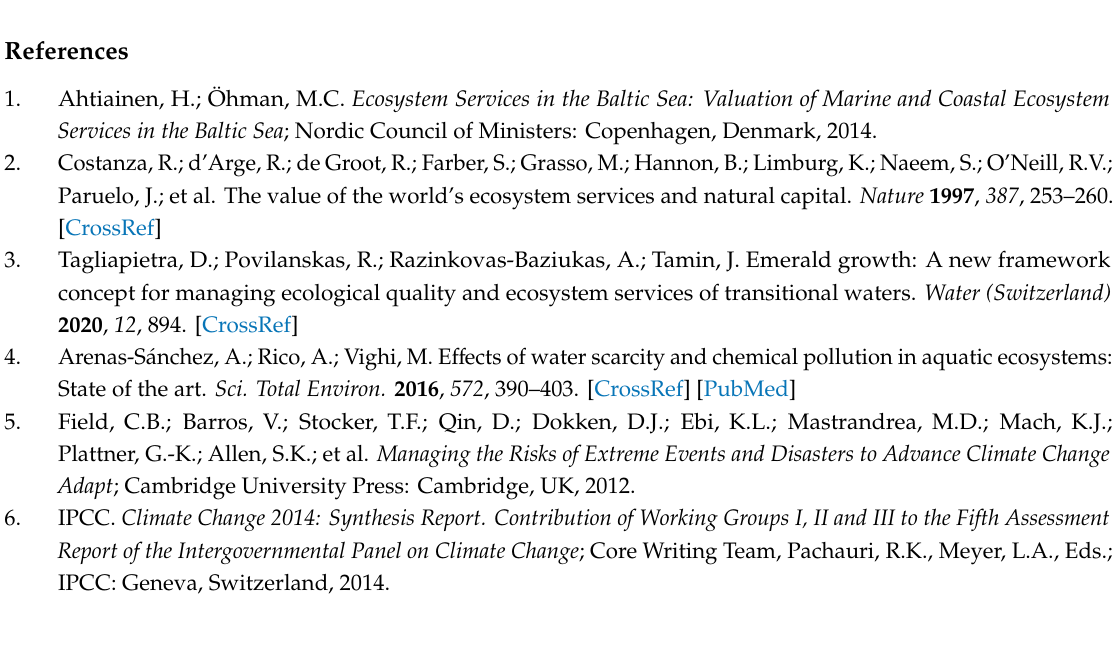
Table S1. Main characteristics observed: flow conditions, dominant macrophytes, bank width, channel width, water depth. Legend for dates: the letters represent the month (Jn: January; Mr: March; M: May; Jl: July; Sp: September; Nv: November); the numbers indicate the year of observations and sampling (17:2017; 18:2018); Table S2. Adopted land cover categories and CORINE Land Cover (CLS) inventory classes present in the study area that integrates each broader category; Table S3. Spearman on ranks correlation coe ffi cients between land cover classes and water physicochemical parameters in the four tributary studies (marked correlations in bold are significant at: p < 0.05; n = 32); Table S4. Spearman on ranks coe ffi cients between land cover classes and sediments physicochemical parameters and potentially toxic metals in the four tributaries assessed (marked coe ffi cients in bold are significant at: p < 0.05; n =